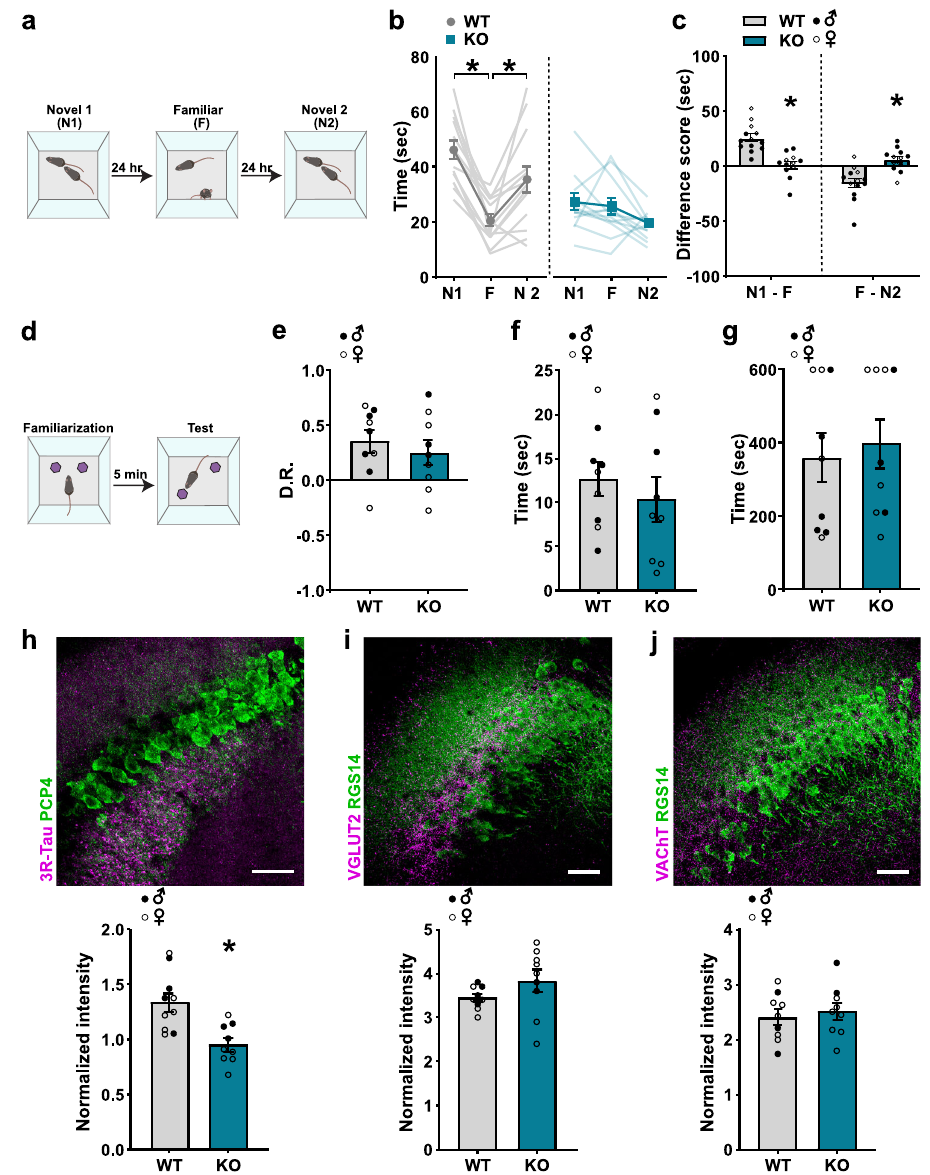
Fig. 1 | Shank3B KO mice have impaired social, but not object location, dis- crimination and mostly typical CA2 afferents. a Schematic of social discrimina- tion test. b WT mice have lower interaction times for familiar (F) than fi rst novel mice(N1)( p =0.0001)andhigherinteractiontimesforsecondnovelmice(N2)than F ( p =0.0112). KO mice do not show different interaction times for F compared to N1 or N2 ( n =13 for WT and n =12 for KO). c Compared to WT, KO mice showed signi fi cantly different difference scores (N1 minus F: p =0.0001; F minus N2: p =0.000491; n =13 for WT and n =12 for KO). d Schematic of objectlocation test. e WT and KO mice showed no difference in discrimination ratios in the object location test, f no difference in time interacting with the objects, and g no differ- ence in time to reach criterion (E – G, n =9 for each genotype). h Top: Confocal image from the CA2 immunolabeled with PCP4 (green) and abGC afferent marker 3R-Tau (magenta). Bottom: Compared to WT, KO mice have lower intensity of 3R- Tau+ afferents in the CA2 ( p =0.002) ( n =10 for WT, n =9 for KO). i Top: Confocal